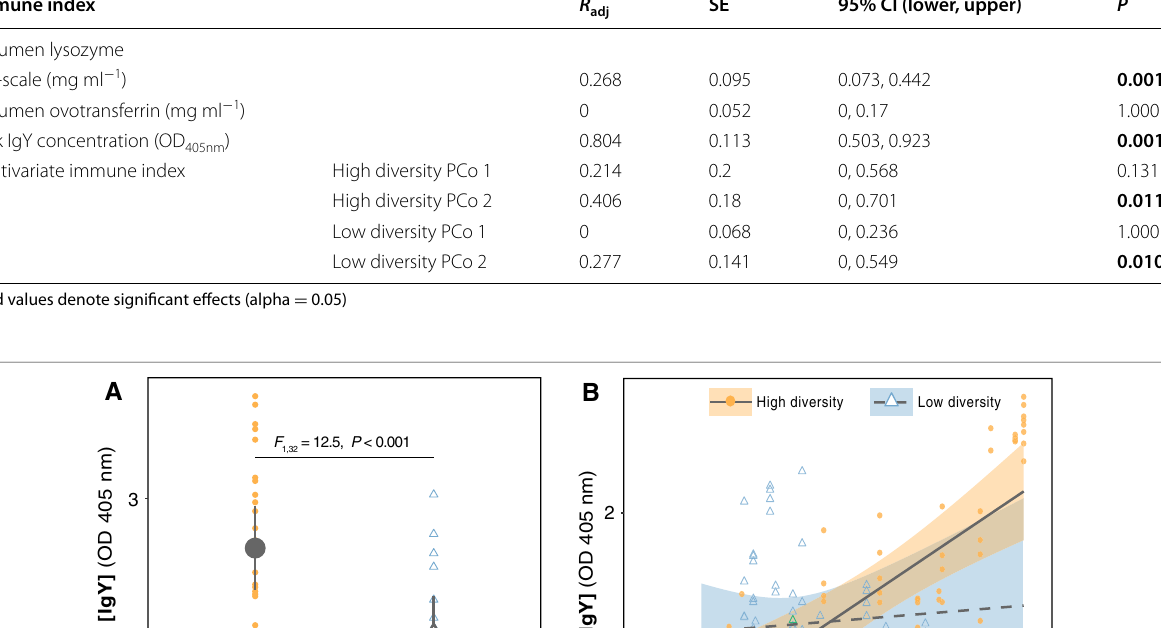
Table 2 Adjusted repeatabilities of egg innate immune function for individual female zebra finches